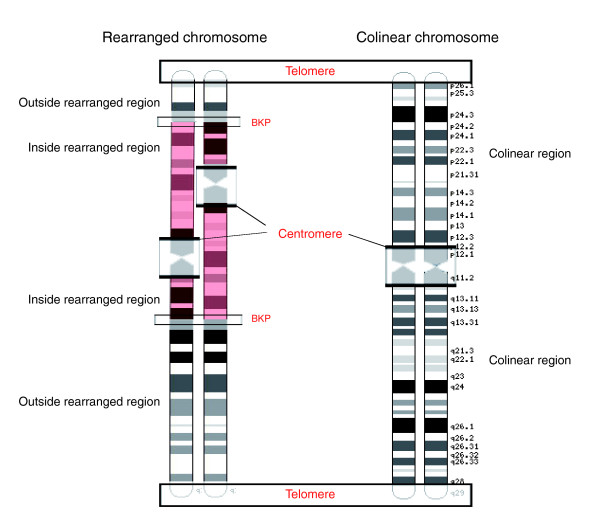
Abstract overview of the chromosomal regions that were included and excluded from our analysis. A colinear and an inverted chromosome are presented. The inversion in the rearranged chromosome is highlighted in red. For every chromosome, regions considered in this paper are labeled in black. Regions excluded from the main analysis (telomeres, centromeres and breakpoints (BKP)) are within boxes and labeled in red.